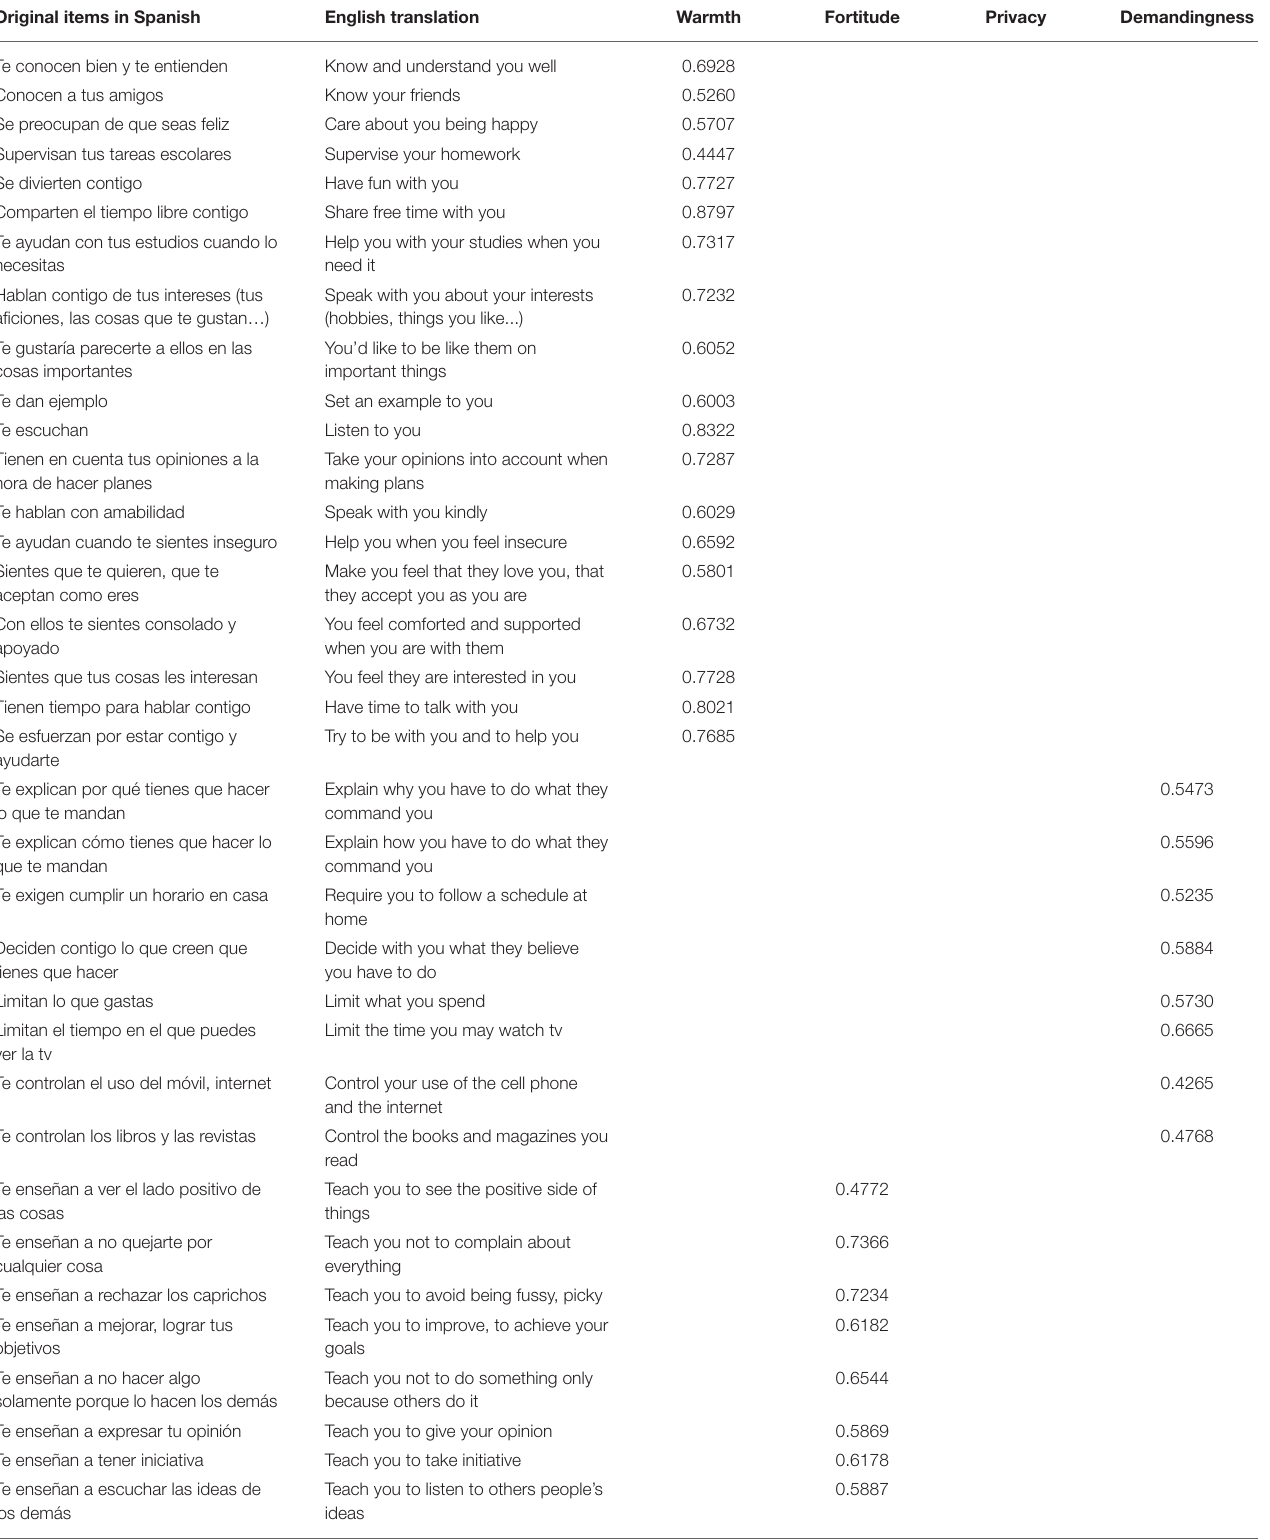
TABLE 3 | Rotated factor loadings for the final EFA solution. Original items in